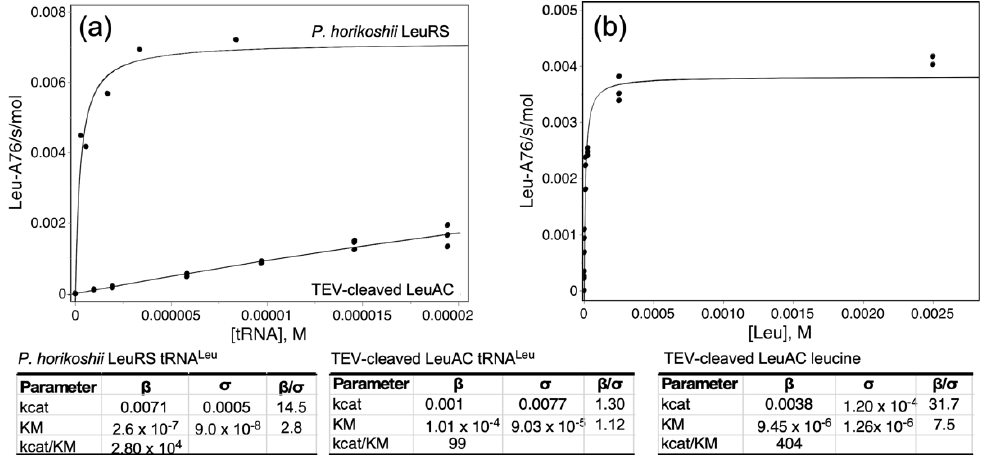
Figure 8. Steady-state kinetic analyses of P.horikoshii LeuRS and TEV-Cleaved LeuAC. ( a ). tRNA Leu - dependence. Results for LeuRS and LeuAC are plotted on the same graph to emphasize the qualitative difference in K M . ( b ). Leucine dependence. Fitted kinetic parameters are given in the tables, together with statistical significance. Measurements for LeuAC were done in triplicate.